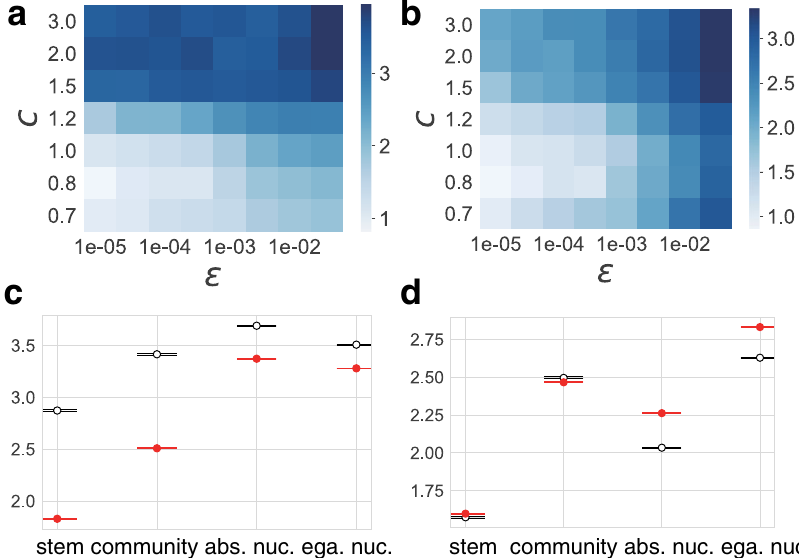
stem community abs. nuc. ega. nuc. Fig. 6 Dependence of the heaviness of tails of wealth distribution on environmental parameters and family systems. a Lightness of the poor tail α given by the power-law fi tting w α . b Lightness of the rich tail β given by the exponential fi tting exp ð(cid:2) β w Þ . Smaller α and β show heavier tails for the poor and rich sides, respectively. c , d Averaged value of α ( c ) and β ( d ) classi fi ed by the dominant family system (stem, community, absolute nuclear, and egalitarian nuclear families) in each society, with error bars. Values for the environmental parameters fi xed to ϵ = 0.0003 and c = 1.5 are plotted in black, whereas those averaged over ϵ = 0.0001, 0.0003, 0.001, 0.003 and c = 1.0, 1.2, 1.5, 2.0 are plotted in